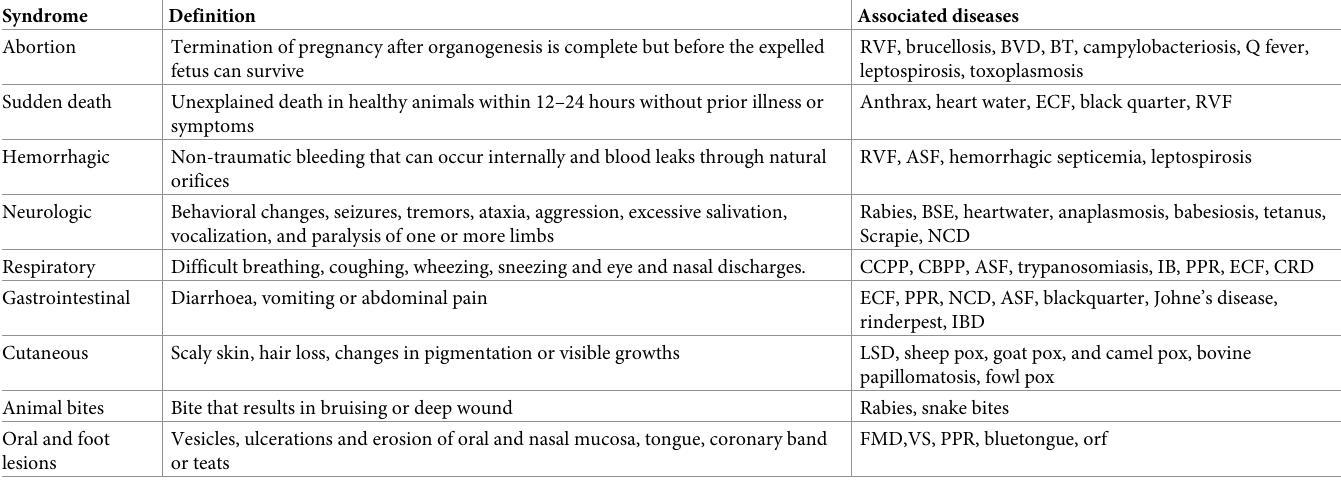
Table 1. Syndromes in domestic animals automatically reported through KABS mobile phone application in Kenya, 2017–2019. Syndrome